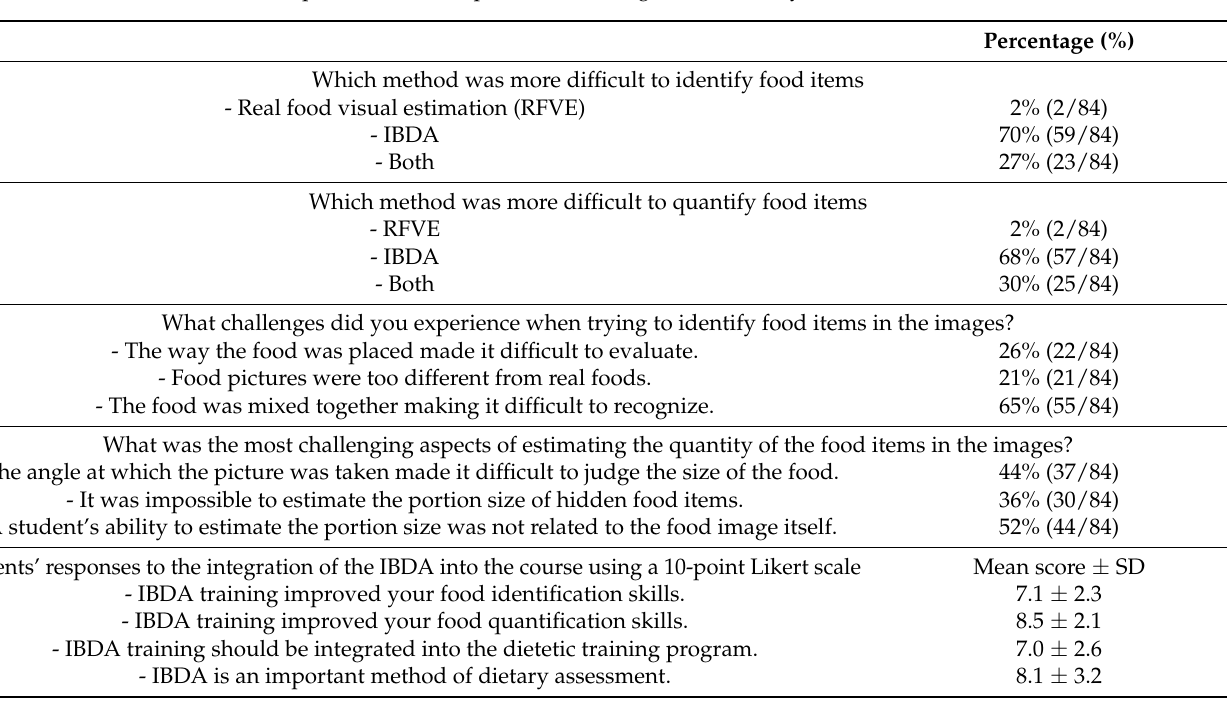
Table 2. Student receptiveness and response to the image-based dietary assessment (IBDA) ( n =